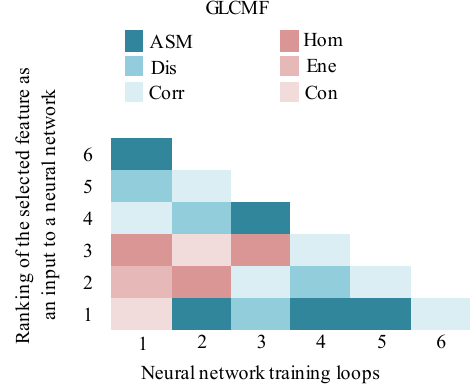
(MSE, RMSE, and MAPE) with cross ‐ validation, training, and test set are mentioned in Table 5. The optimal neural network was polished by conjoining 5GLCMF at the 2nd loop. The best GLCMF were ASM, homogeneity, contrast, dissimilarity, and correlation, respec ‐ tively. The ideal parameters of activation function, hidden neurons, and maximum itera ‐ tions at the fewest value of RMSECV (2.148) were hyperbolic tan, (6,10), and 175 repeti ‐ tions, respectively. The BPNN ‐ GLCMF ‐ 5 model performed better than the BPNN ‐ GLCMF ‐ 6 model. The high ‐ level model enhanced the R 2 from 0.641 to 0.679, MAPE from 3.151% to 2.938%, RMSE from 2.757 to 2.607, MSE from 7.599 to 6.794, and Acc from 0.968 to 0.971.